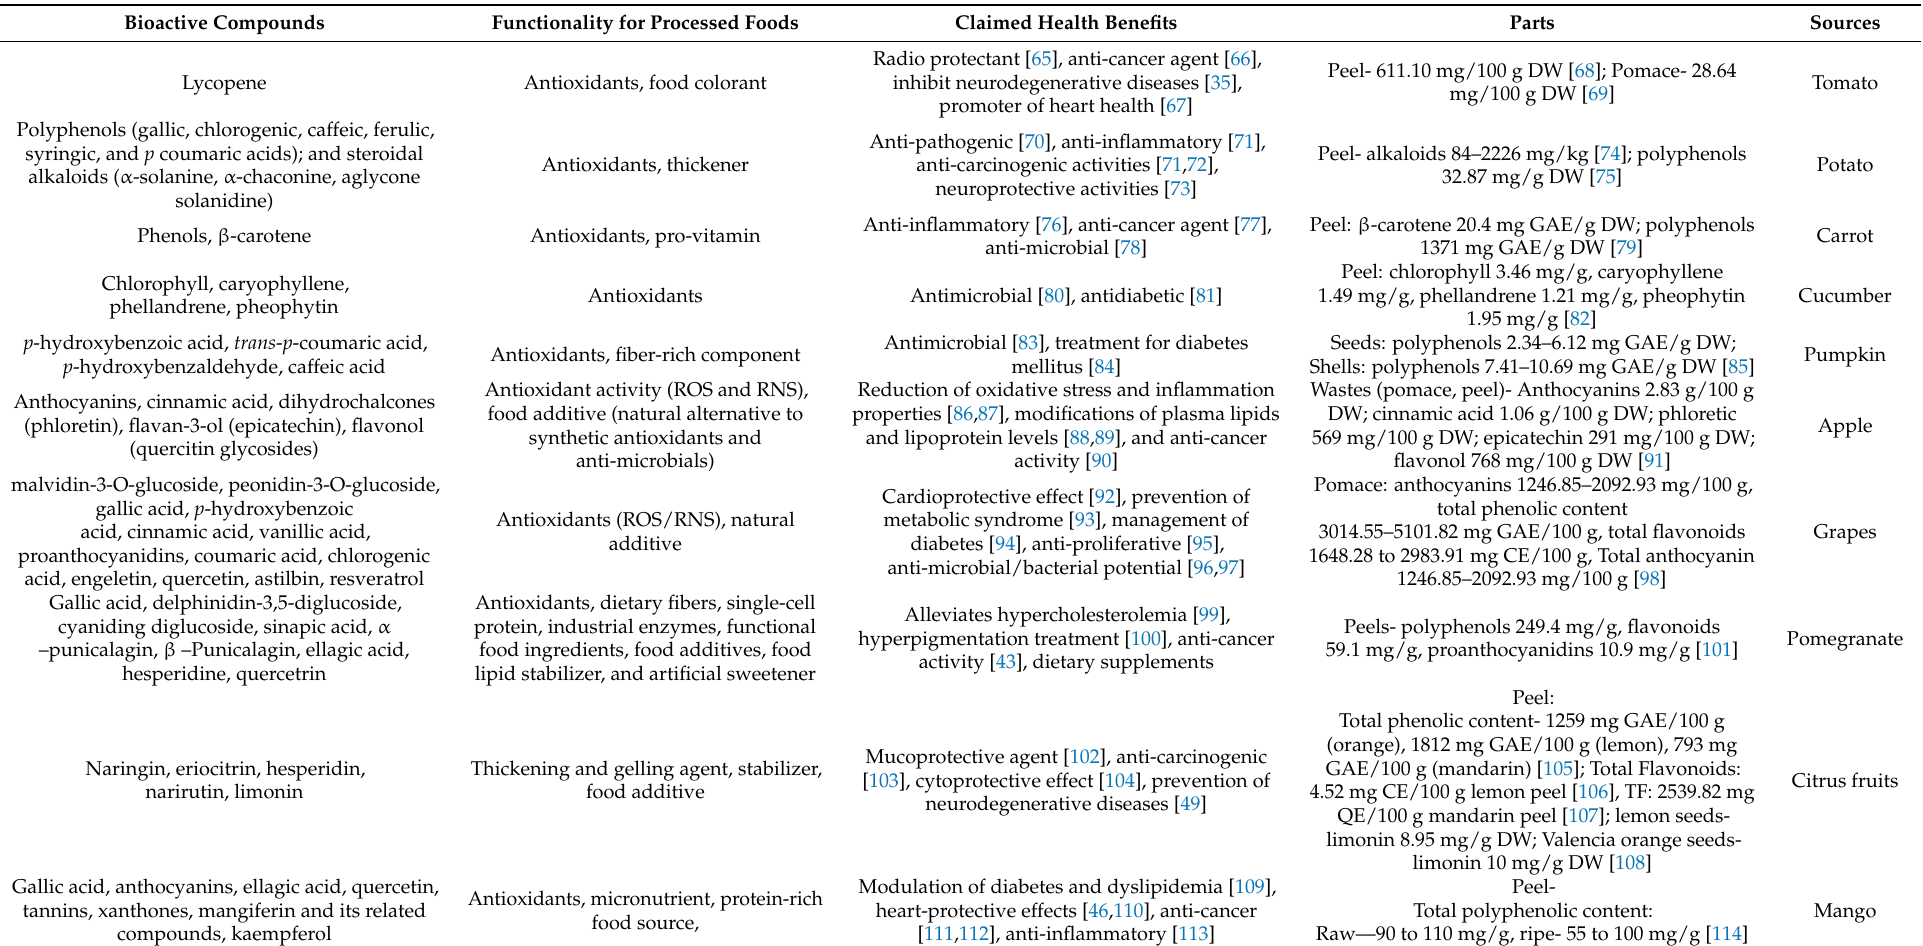
Table 1. Different sources of bioactive compounds from plant products and their key functional